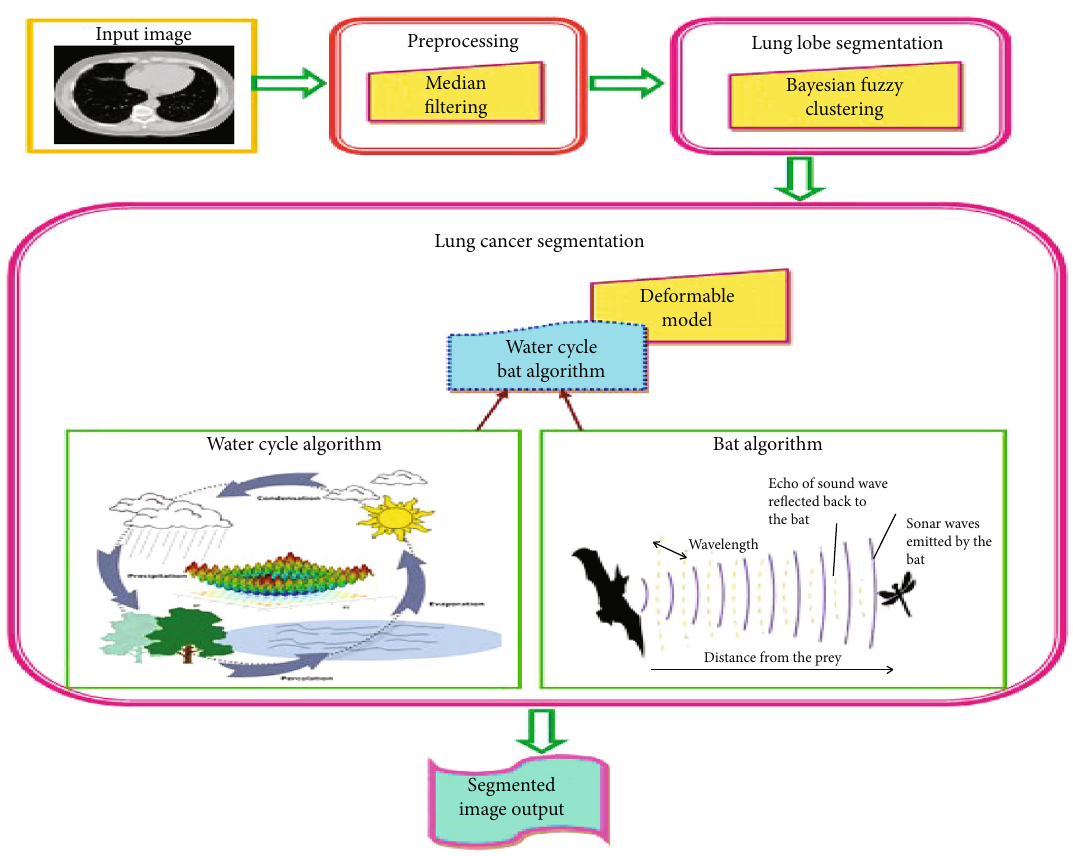
Figure 1: Block diagram of the proposed WCBA-based lung cancer segmentation